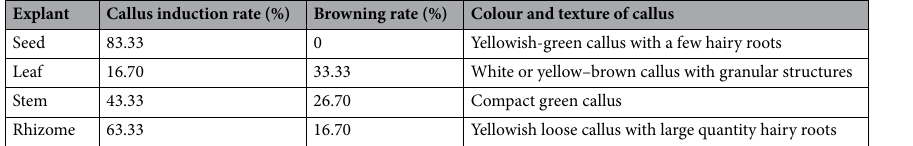
Table 3. Comparison of callus induced by different explants.